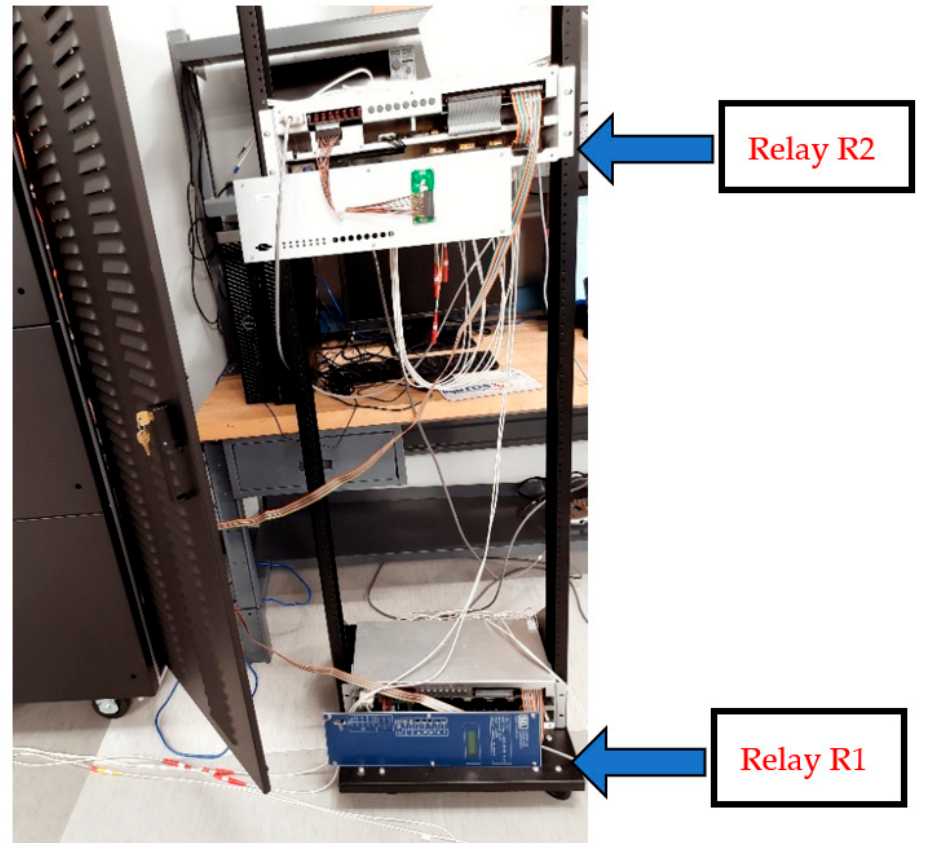
Figure 15. Relay R1 and R2 used for experiment. Table 2. Scaling factors for SEL-351 relay.